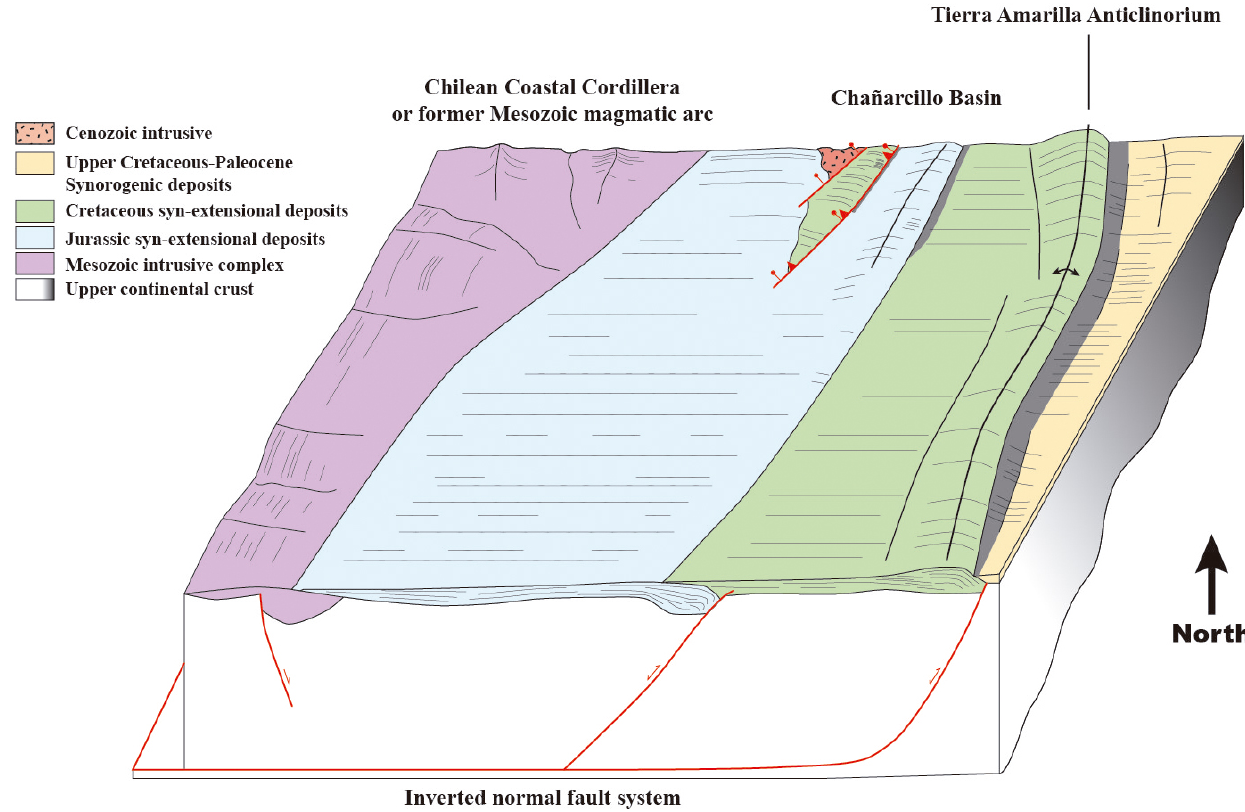
Figure 11. Illustration of the schematic 3-D current architecture of the central section of the Chañarcillo Basin, based on the results